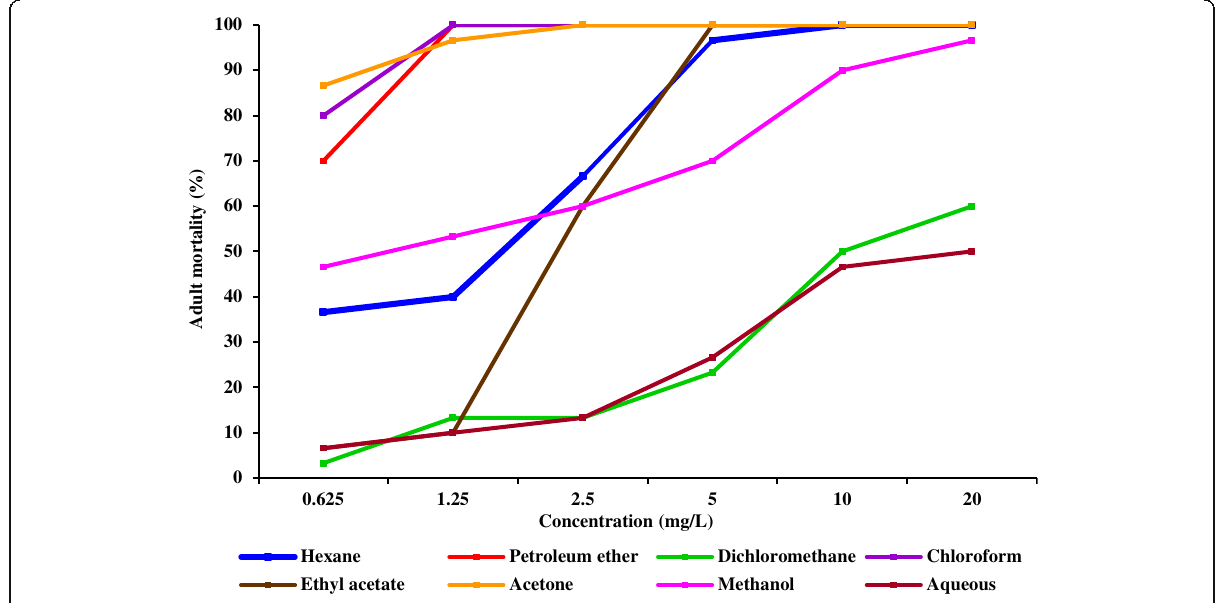
Fig. 3 Percent adult mortality of Sitophilus oryzae on exposure to Nicotiana tabacum leaf extracts at 72 h